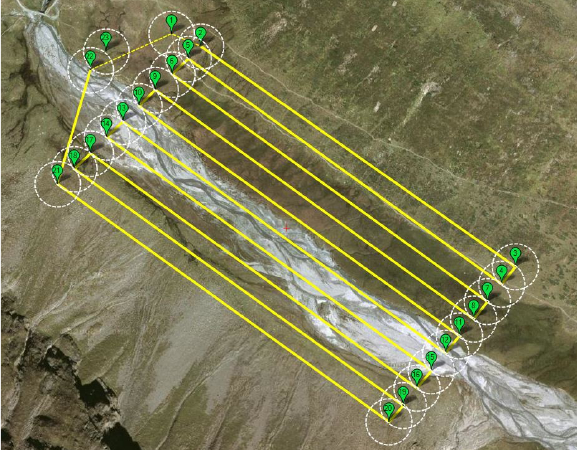
Figure 14. Plan of the remotely piloted aircraft system